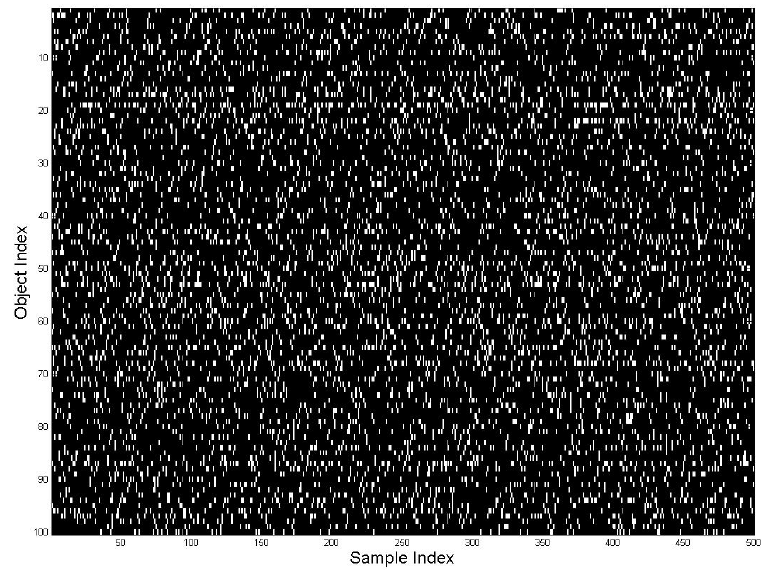
Figure 3. Data, same as Figure 2, randomly sorted by situations (horizontal axis), as available to the DL algorithm for